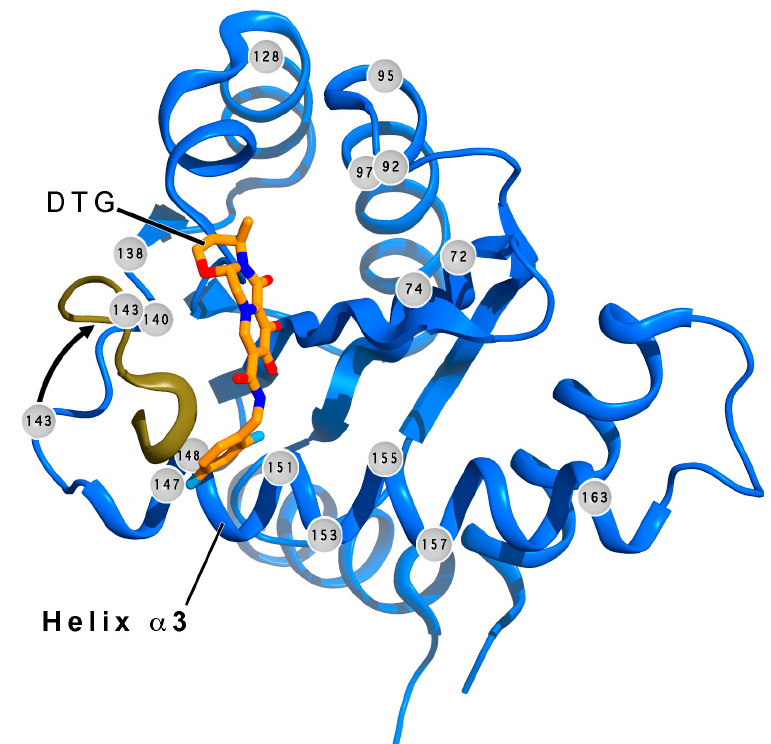
Figure 3. Locations of resistance mutations in IN. The locations of commonly seen IN-resistance mutations (gray orbs with residue numbers) [131,138–145,147,149,150] are shown in a ribbon diagram of the catalytic core of IN (blue, apo-enzyme structure). The shown apo-structure (light blue, PDB accession ID: 4CJE) was superimposed on that of the DTG-bound IN-orthologous prototype foamy virus (PFV) intasome (PDB accession ID: 3S3M). DTG (tan carbon atoms, red oxygen atoms, blue nitrogen atoms, and cyan fluorine atoms) is shown in its binding pocket. The loop (gold) containing the Y143C/H/R mutation site (magenta) rotates toward the bound DTG (black arrow) in the PFV structure. Many mutation sites are seen on helix α 3 (nomenclature from ref. [151] ) and at (or near) the INSTI binding pocket. The two structures were superimposed in Coot®, and the figure was generated using PyMol®, with annotation in Photoshop®.